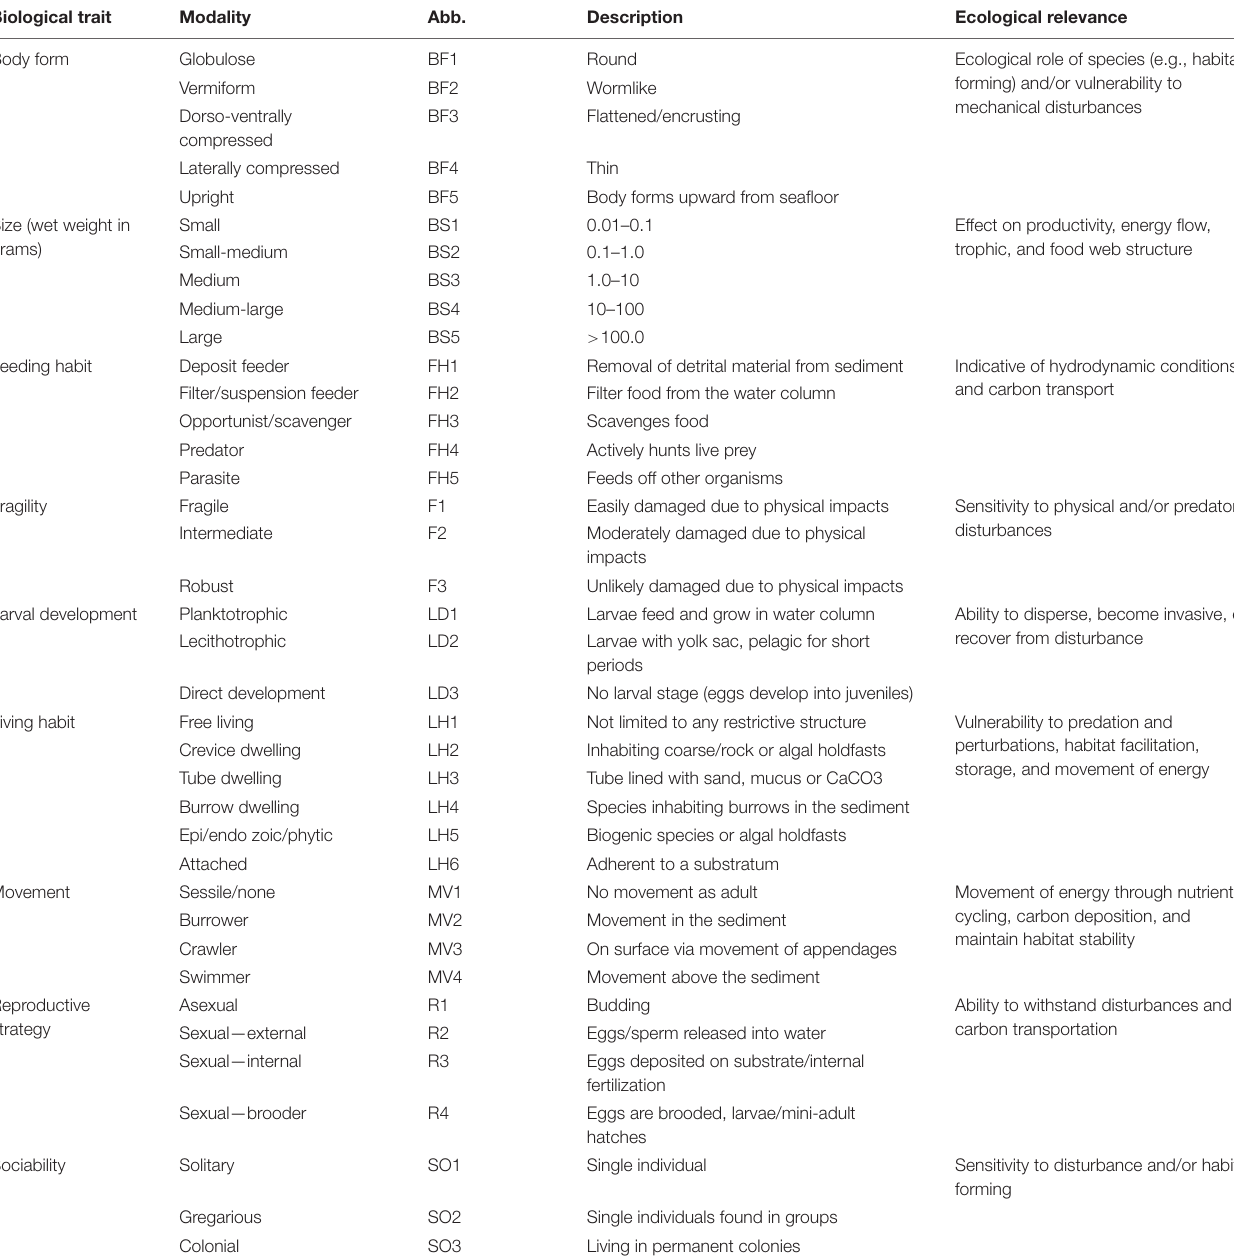
TABLE 1 | Biological traits, modalities, descriptions, and ecological relevance are shown for epibenthic invertebrates collected in the Chukchi and Beaufort seas, following Degen and Faulwetter (2019). Biological